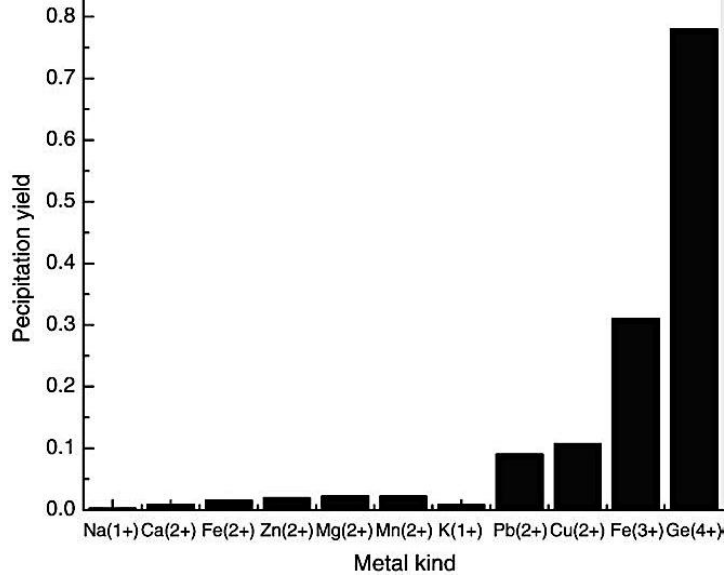
Figure 9. Binding ability of various metals in polymetallic system with tannins